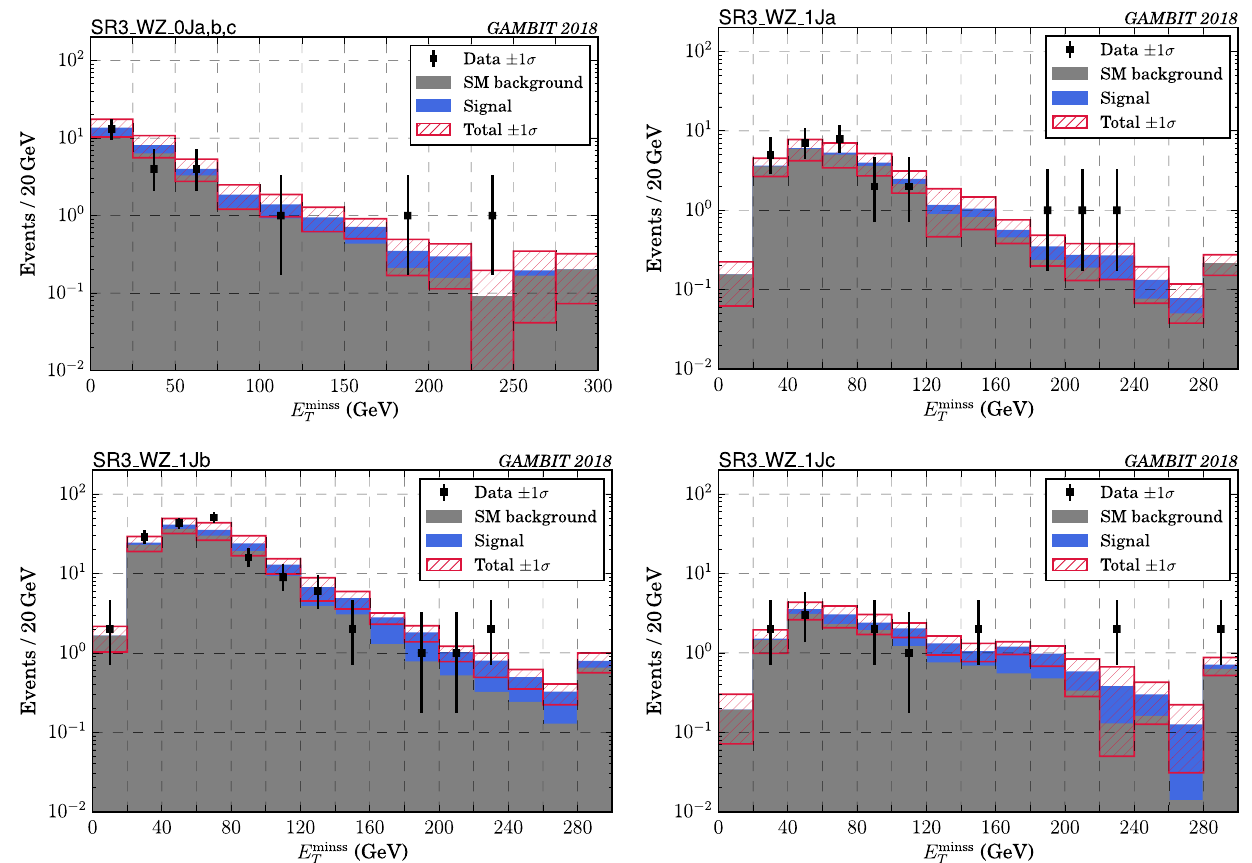
Fig. 12 Distributionofmissingtransverseenergyinthe3leptonsignal regions of the traditional ATLAS multilepton analysis, after applying all selection requirements. The grey bars show the total SM background (taken from Ref. [116]) and the stacked blue bars show the signal for